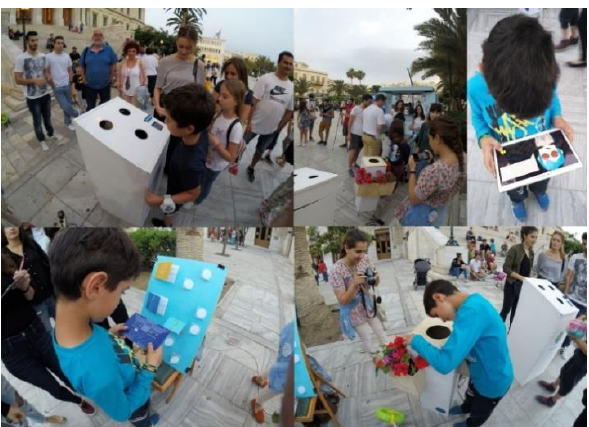
Figure 9. Visitors interacting with the projects at the central square of Hermoupolis,